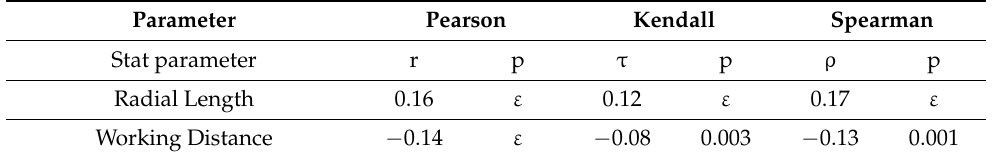
Figure 10. Performance of non-uniform model for radial measurements: ( A ) effect of object length, ( B ) effect of working distance. Table 3 quantifies the effect of radial length of the object and working distance on the magnitude of error from the non-uniform model. Based on Table 3, we see the magnitude of error has very week associations with the working distance and length of the target object. Table 3. Correlation coefficients of non-uniform model for radial measurement error. The symbol ε denotes a p < 0.0001.